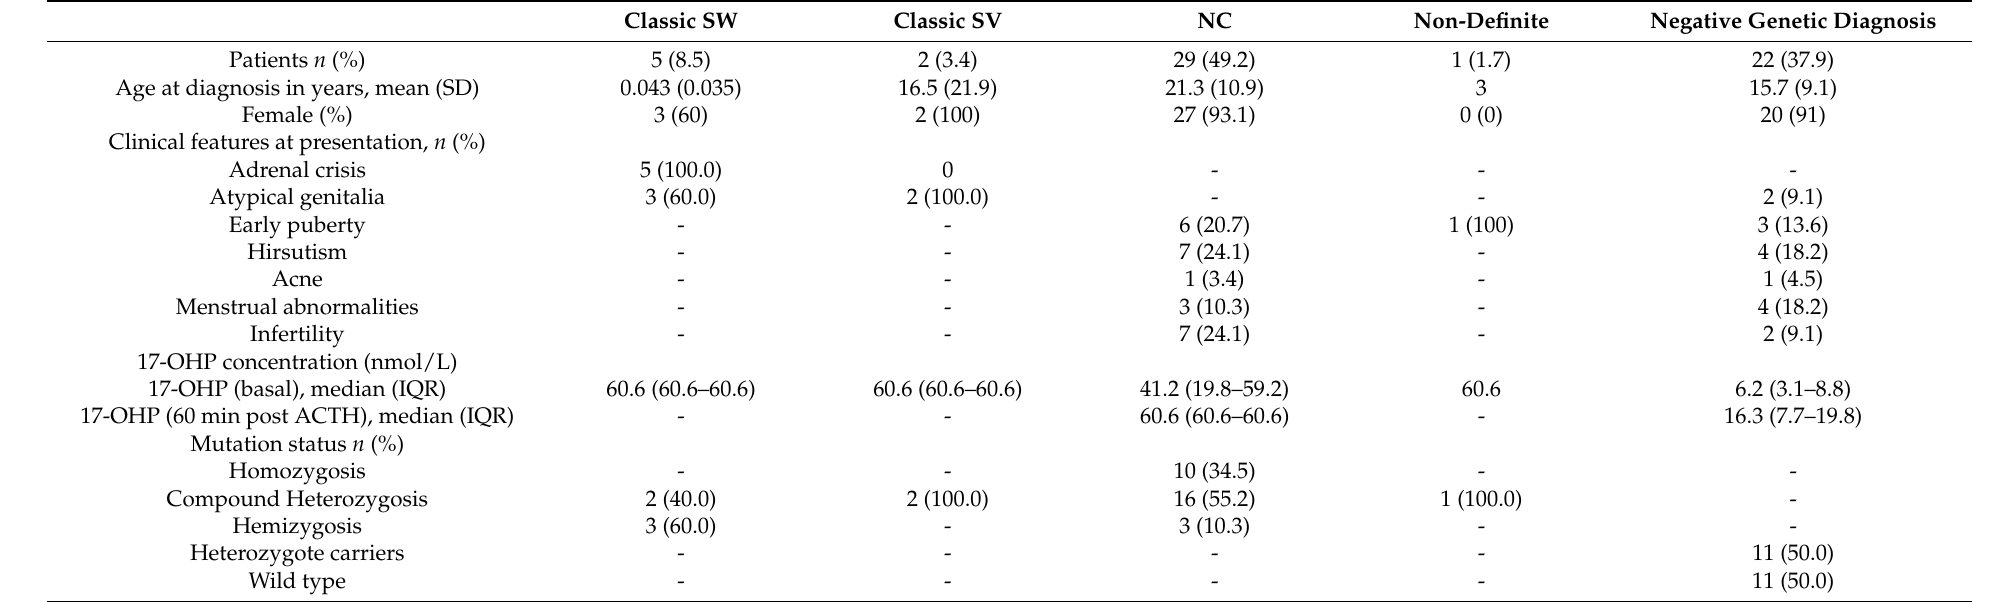
Table 1. Summary of clinical, biochemical, and genetic information of patients at